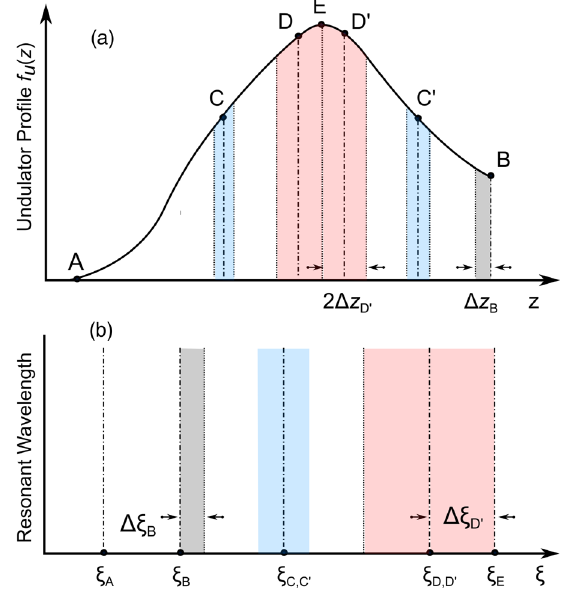
FIG. 11. Generic undulator profile vs longitudinal distance z is schematically depicted in the upper plot. The bottom plot shows corresponding resonant wavelengths (A4) and resonances around them. For ξ < ξ and ξ > ξ , the solution to (A1) is given by A E (A2). For wavelengths ξ , whose resonances are completely within the integration region and isolated such as the stationary points C and C 0 , the solution (A3) is applicable. For the end points A and B , the value of the integral is half of (A3). In the vicinity of the Þ ¼ 0 , Eq. (A10) should be degenerated point E , ψ 00 ð z E